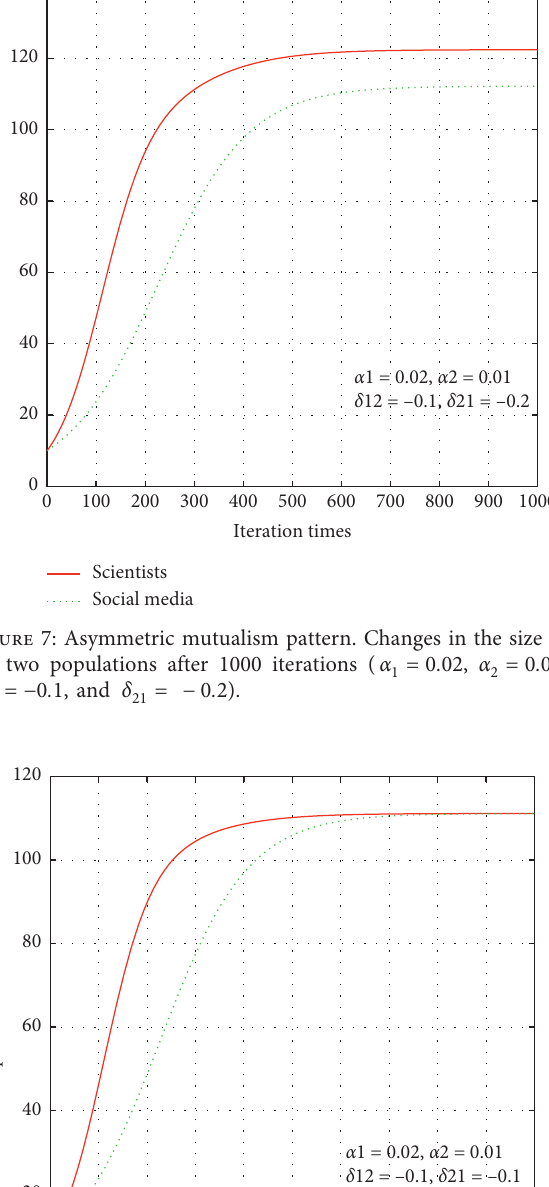
� 0 . 02, α � 0 . 01, 1 2